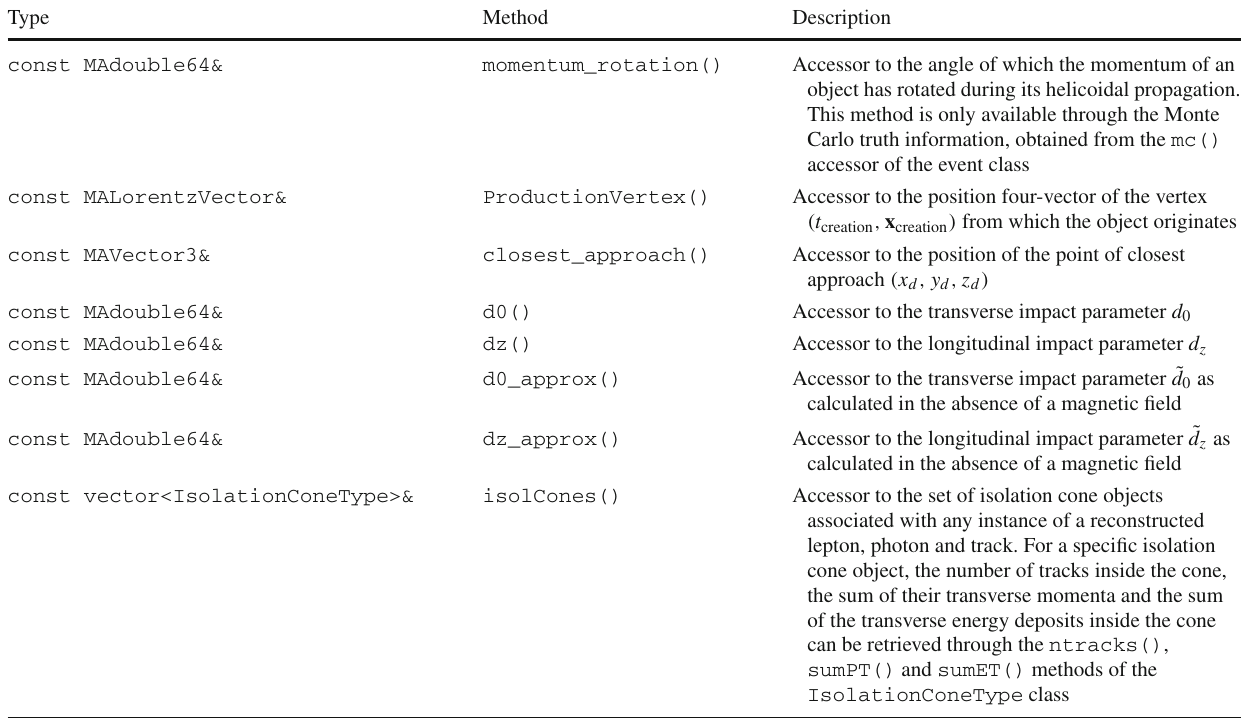
Table 5 List of accessors relevant for LLP analysis implementa- tions in MadAnalysis 5 . We indicate the type, in the Mad- Analysis